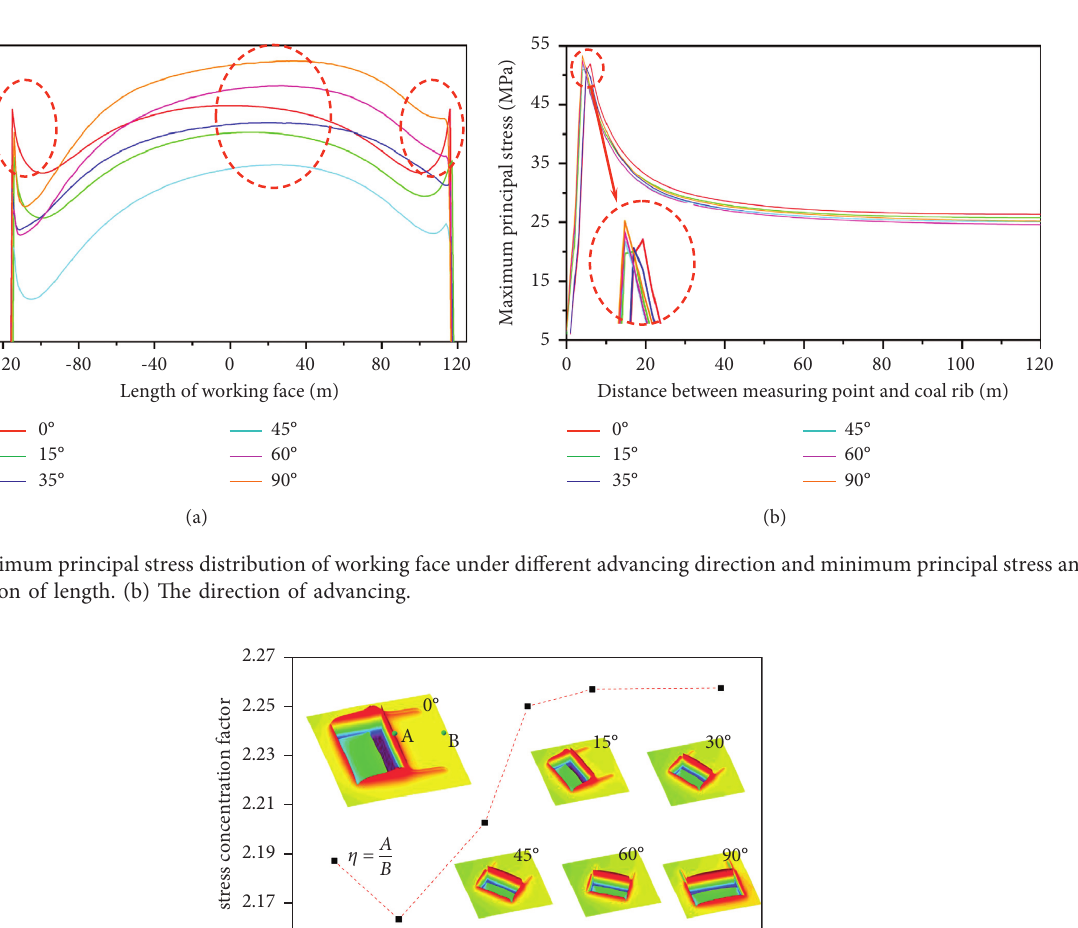
Figure 7: Influence of advancing direction on maximum principal stress distribution of working face. (a) 0 ° . (b) 15 ° . (c) 30 ° . (d) 45 ° . (e) 60 ° . (f) 90 ° .